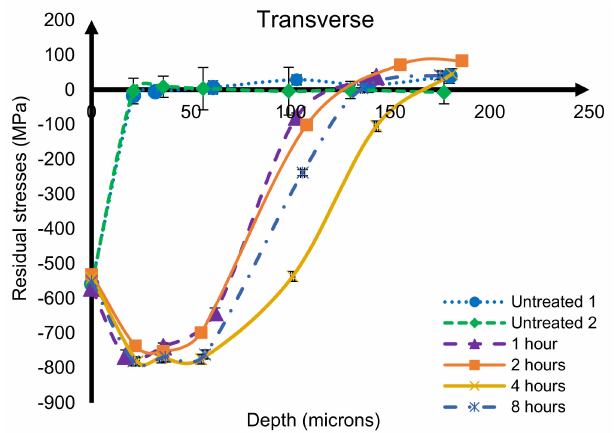
Figure 9. Residual stress profile of IN718 at − 130 mm in the transverse direction.